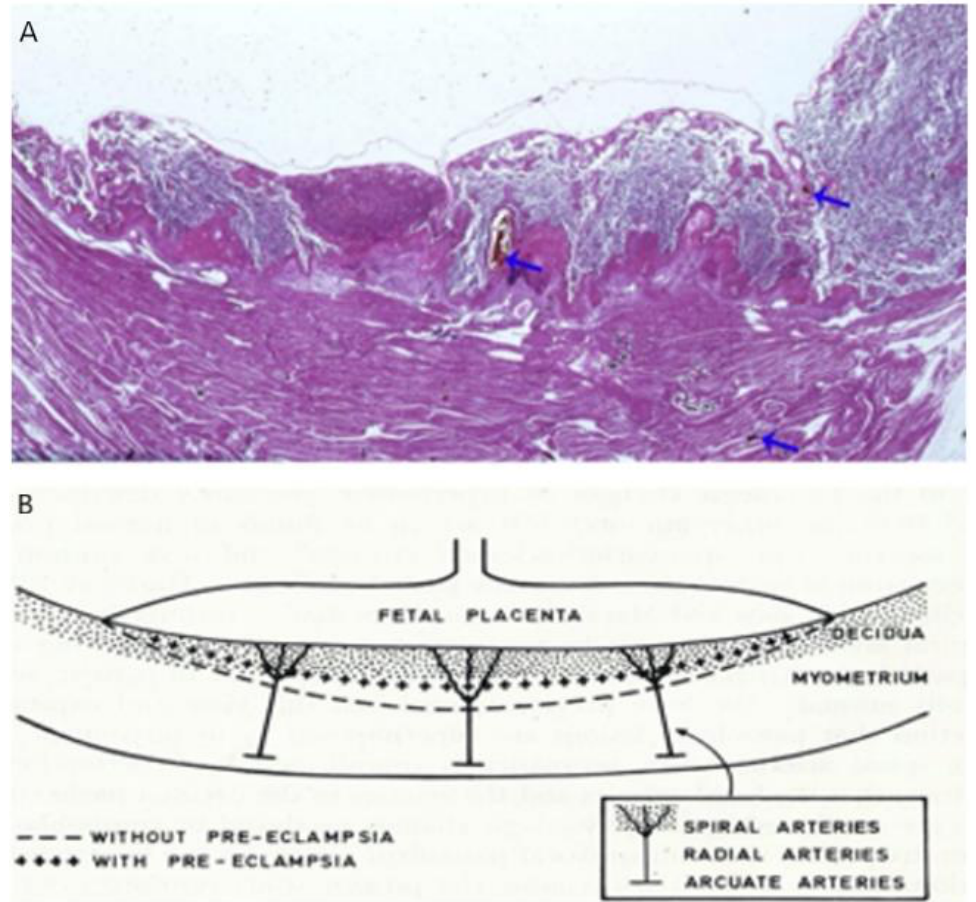
Figure 3. ( A ) Microscopic appearance on H& E staining of an infarcted zone of a uterus with placenta in situ in severe preeclampsia. The intravascular injection of Chinese ink via the uterine artery appears as patent radial and spiral arteries in the central part of the placental bed (blue arrows on the right and center) but absent arteries are associated with a large intervillous thrombus (blue arrow on the left). ( B ) Schematic diagram of placental vessels’ transformation showing normal (bottom line) and defective deep placentation. [21].